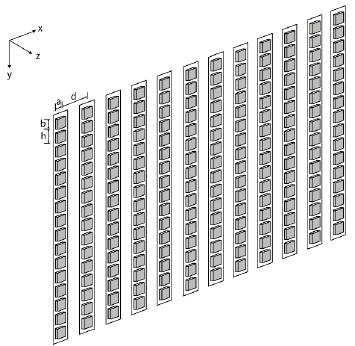
Figure 3. Structure of one element (“multi-cell” combined by parallel connection). a , b and h represent element (“cell”) width, “cell” length, and “inter-cell” spacing, respectively.